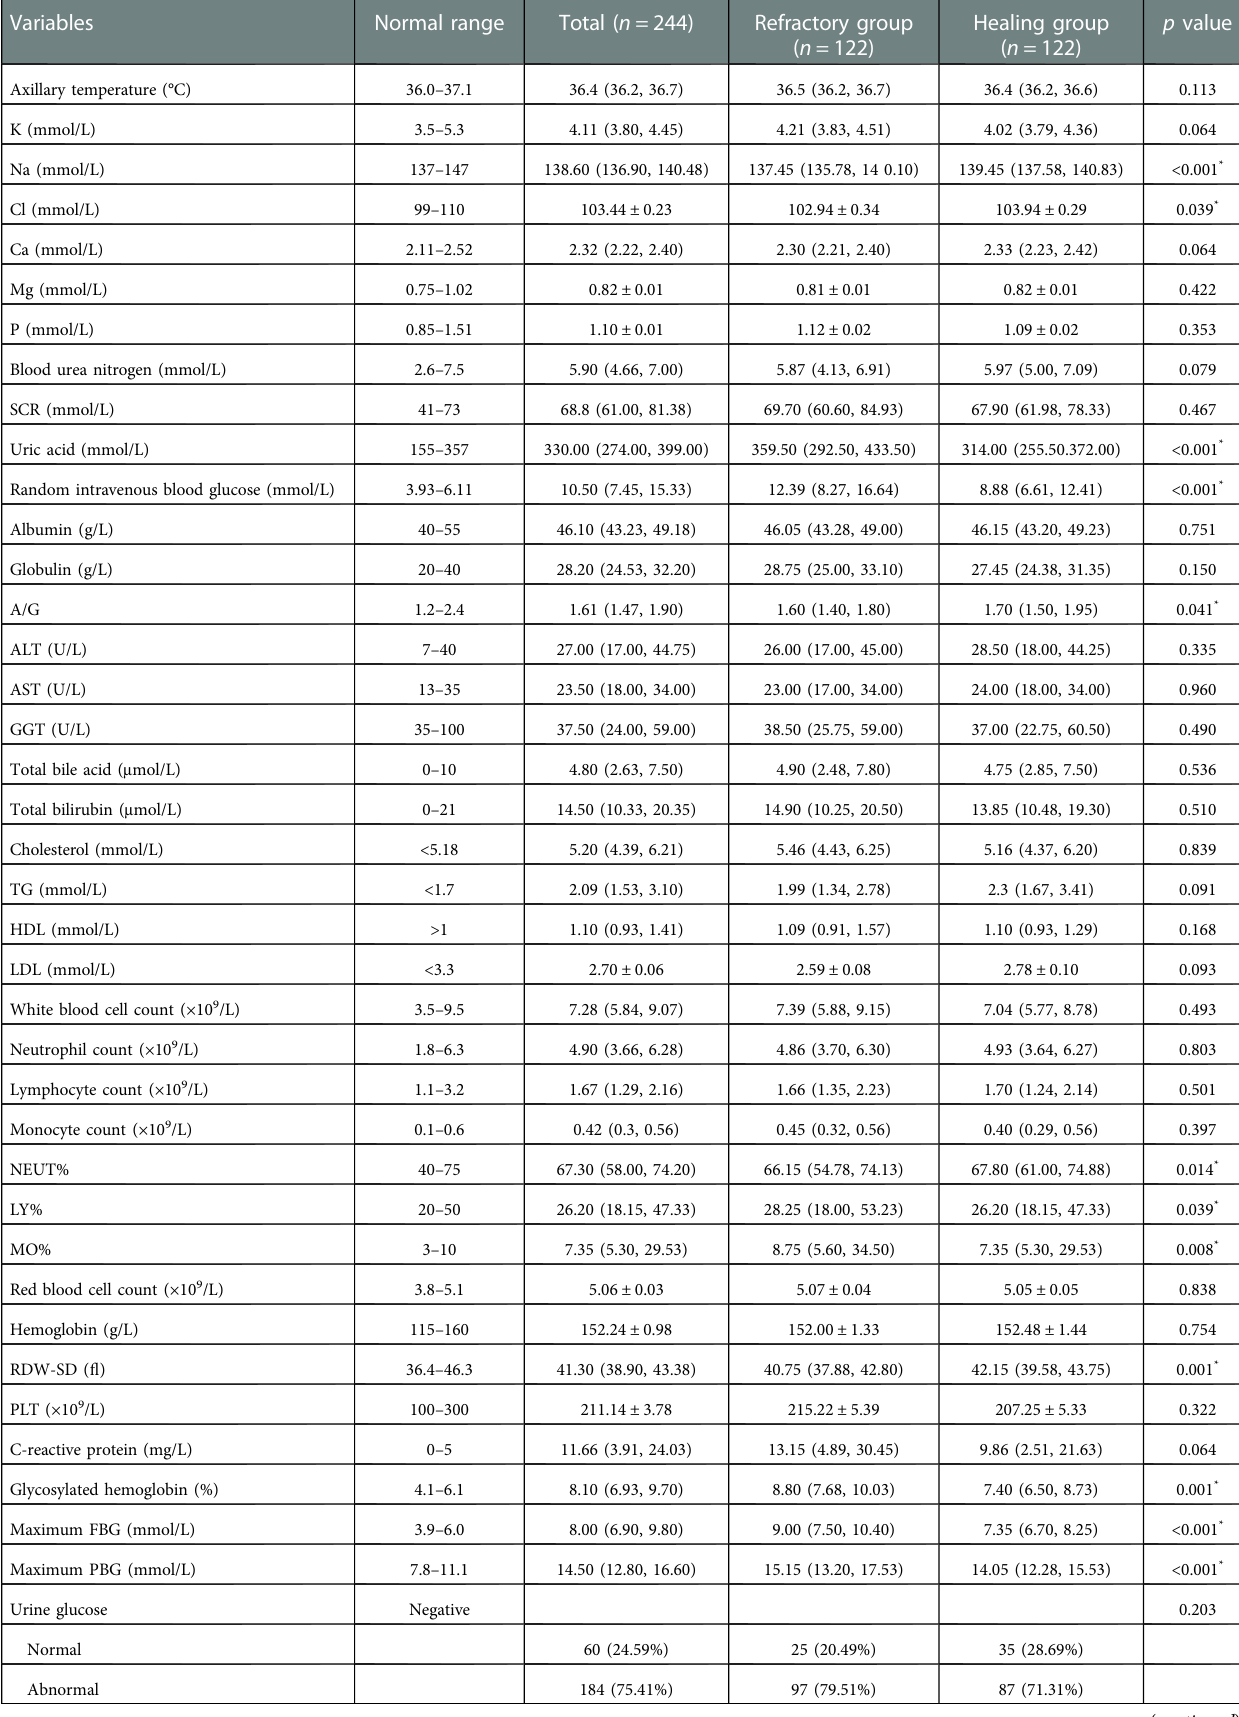
TABLE 2 Laboratory and ancillary tests on admission